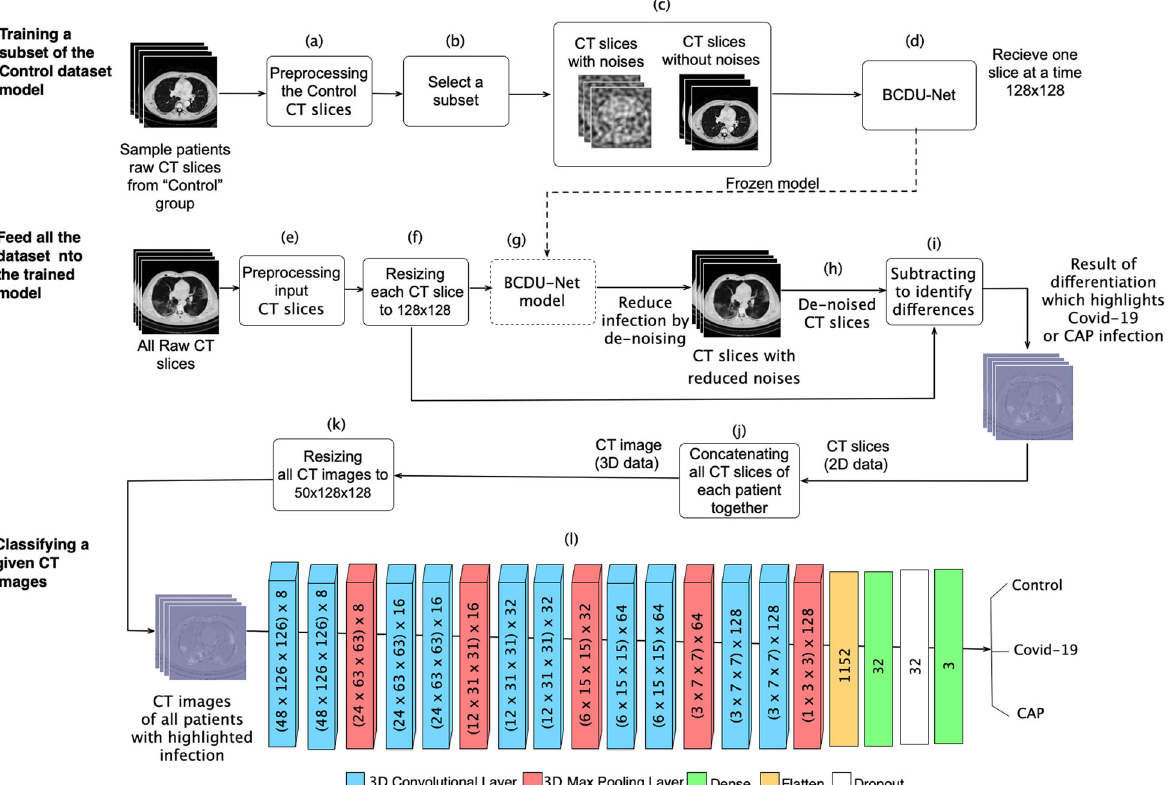
Fig. 8 Multistep pipeline of deep learning algorithms to detect Covid-19 from CT images. Upper part, Training step of the model for learning the structure of Control CT slices. Middle part, Images subtracting and lung reconstructing from CT slices with highlighted Covid-19 or CAP infection (violet color). The results of step “ i ” are a 2D image. The slices at z axis concatenate to generate 3D CT image, the input of CNN model. Lower part, CNN model classi fi es the images that were constructed in the previous stage. To integrate this pipeline into an application the user needs to start from stage (middle part) and then the CNN algorithm recognizes whether the given CT images of a given patient presents Covid-19, CAP, or control. The number outside the parentheses in CNN model, present the number of channels in the CNN